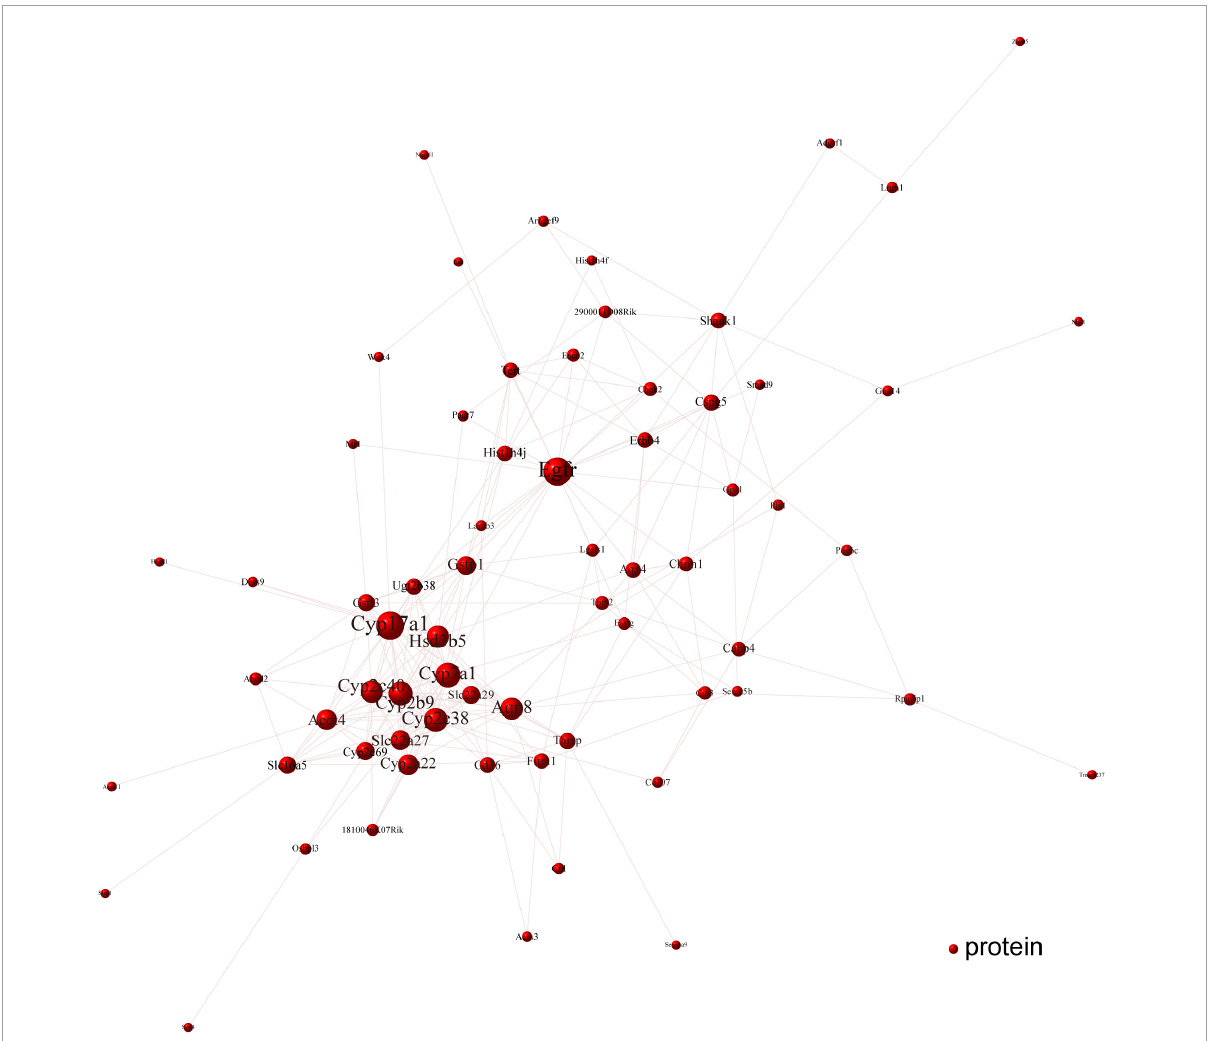
FIGURE7 PPI network analysis was performed with the overlapped DEGs. The connections between nodes indicate the interactions between the proteins encoded by the overlapped DEGs (red nodes). The visualization for Cori-dependent hub proteins were selected with a PPI score over 0.9, such as Cyp7a1 , Hsd3b5 , Cyp17a1 , Cyp2c38 , Cyp2b9 , Egfr , Erbb4 , Cyp2c40 , Gna14 , Chrm1 , Cspg5 , and Gpc1